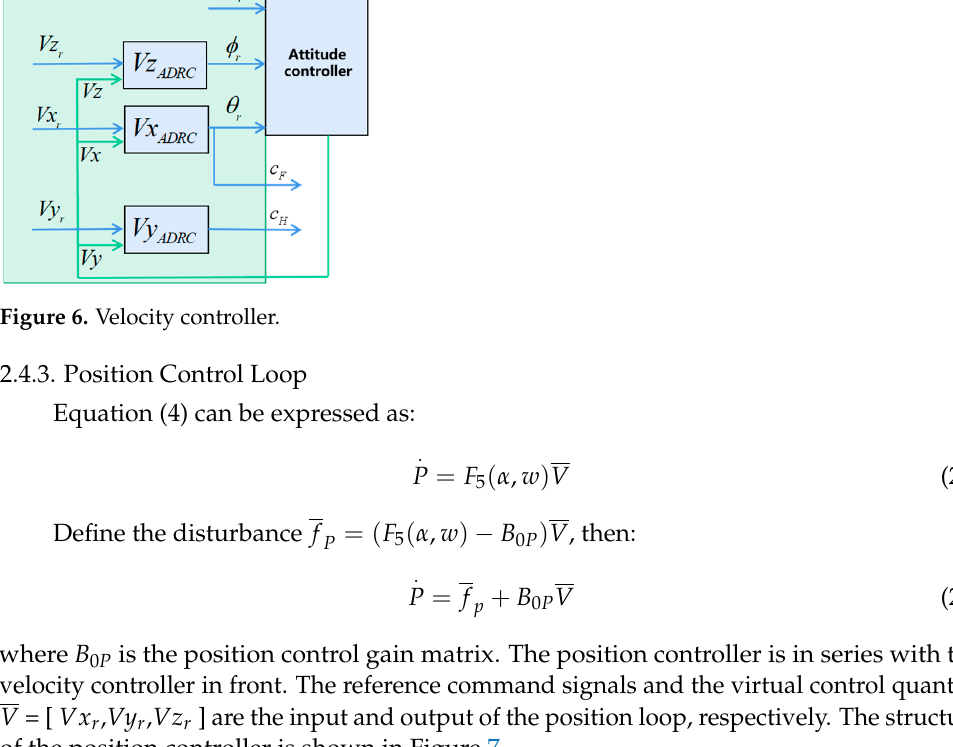
Figure 8. GA-PSO algorithm combined with ADRC control system. Figure 9. GA-PSO flow chart.